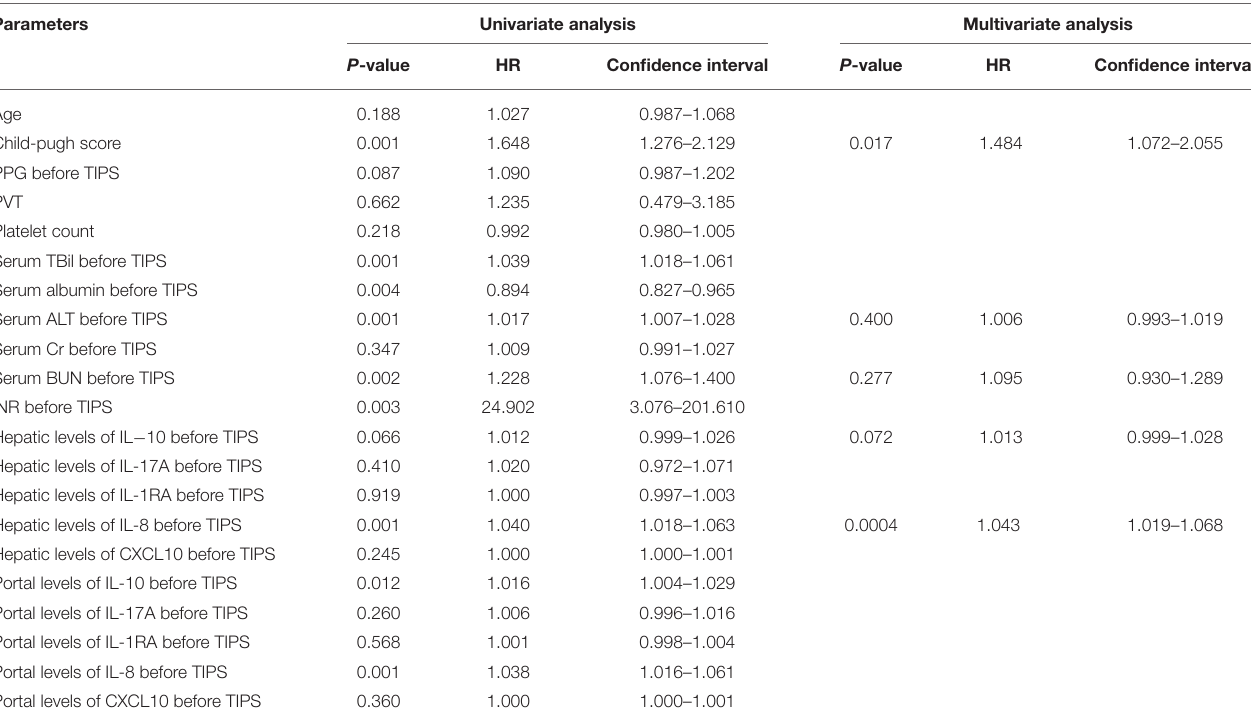
TABLE 3 | Parameters correlating with survival in univariate Cox-regression analysis and in multivariate Cox-regression time-to-event analysis.